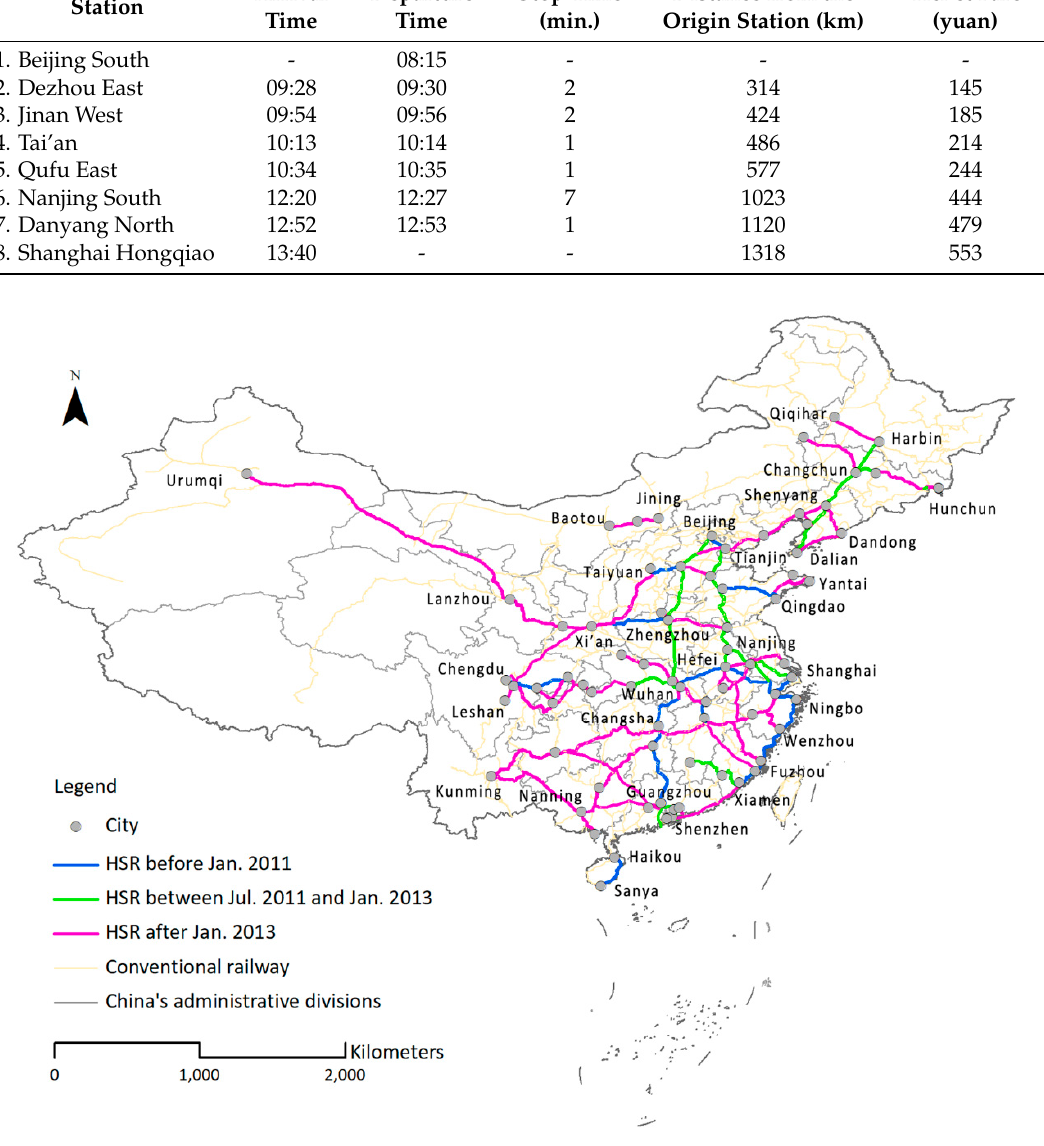
Figure 2. Spatial distribution of rail lines during different stages.